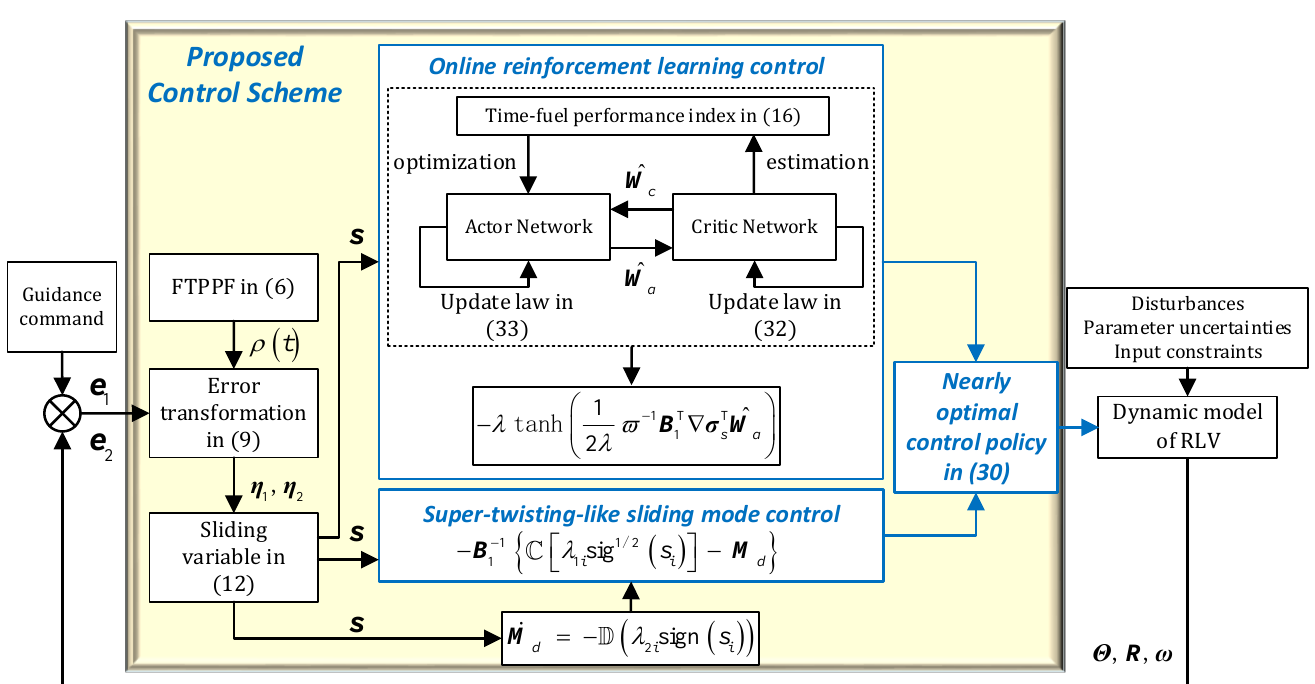
Figure 1. The block diagram of the proposed control